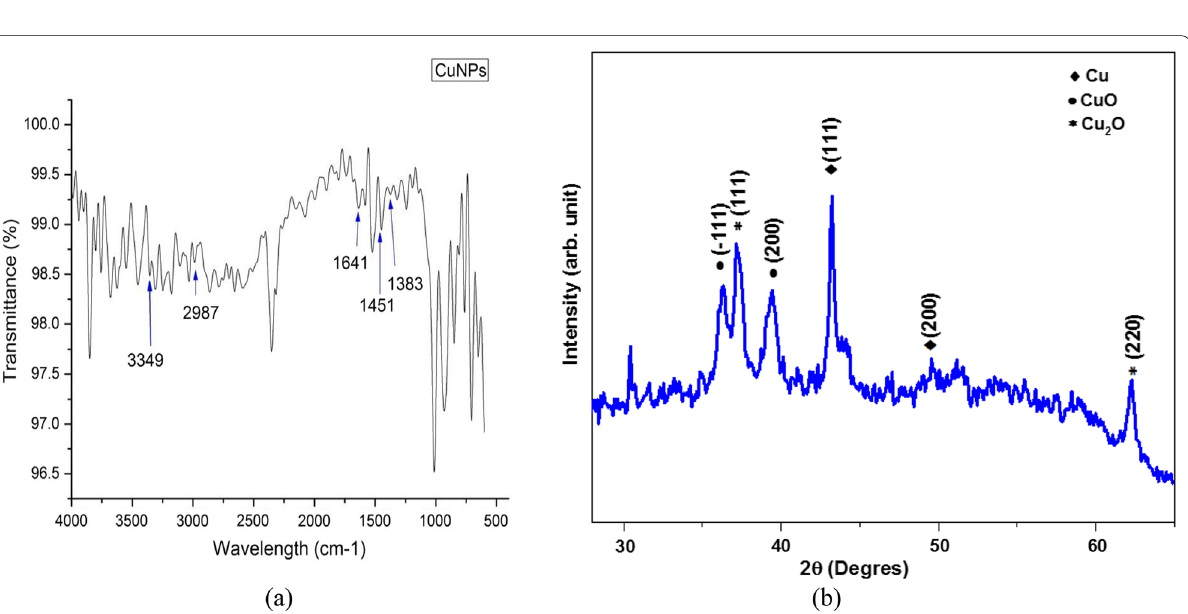
Fig. 2 a Graph below represents the FTIR image b XRD analysis of synthesized copper